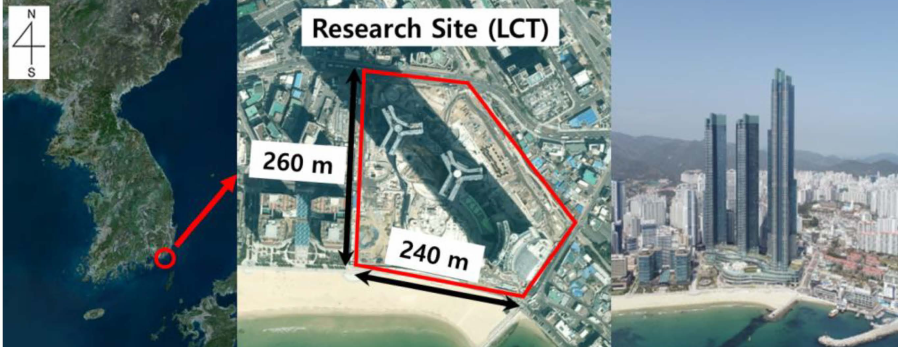
Figure 2. Geographical location and surrounding area of the LCT residential complex (self-taken).